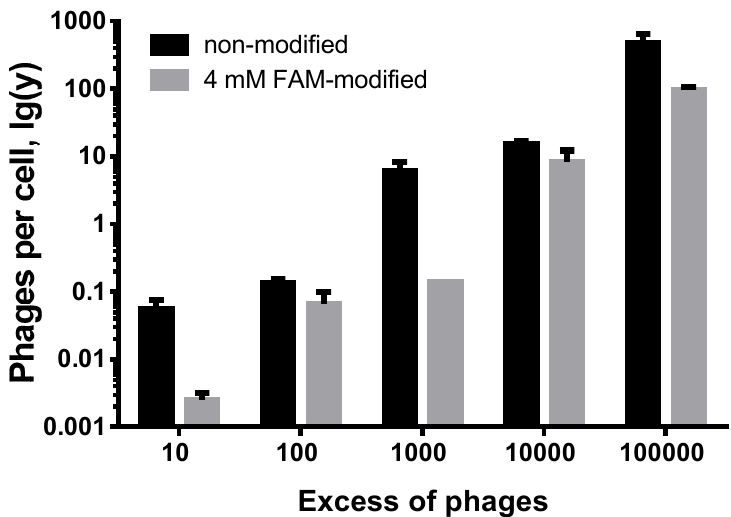
Figure 8. The dependence of the excess tumor-targeting phages incubated with fixed amount of tumor cells MDA-MB 231. There was an excess of phages in relation to cells by a factor of 100,000. The number of penetrated unmodified phage particles was 476 per 1 tumor cell. At the same time, the number of penetrated modified phage particles was dramatically lower (96 phages/cell). We assume that a tumor-targeting peptide can be modified with a fluorescent dye, which leads to a decrease in the affinity of the modified phages for tumor cells. 3. Discussion Bacteriophages could be used as vehicles for the development of theranostics or im- aging agents. The main advantages of these molecules are their size, high solubility, and multivalency. The latter is important because both the payload and signaling motifs can be conjugated with the shell of the virus to significantly increase cellular uptake and signal intensity [21,22]. The choice of fluorophore may be due to various reasons: (1) subsequent phage modification with an oncolytic drug or another molecule that has its own fluores- cence; (2) the need for certain free amino acid residues; or (3) the subsequent use of the developed drug in an in vitro, in vivo, or ex vivo system. The choice of payload (the on- colytic drugs or other molecules) that can be conjugated to viral particles may be due to the following reasons: (1) increased binding to target cells and (2) effects on tumor cells. A great deal of research has gone into phage modification using conjugation chemis- try or bioengineering, with the aim of elaborating upon theranostics or imaging agents. Breakthroughs in the history of phage-mediated gene therapy was performed by Larocca et al. They demonstrated that a filamentous phage modified by fibroblast growth factor (FGF2) and a functionally active green fluorescent protein (GFP) can target and deliver into mammalian cells [23]. Further, modified phages have also been shown to have appli- cations for the characterization of breast cancer cells using fluorescence microscopy [24], for the intracellular delivery of functional exogenous proteins to a human prostate cancer